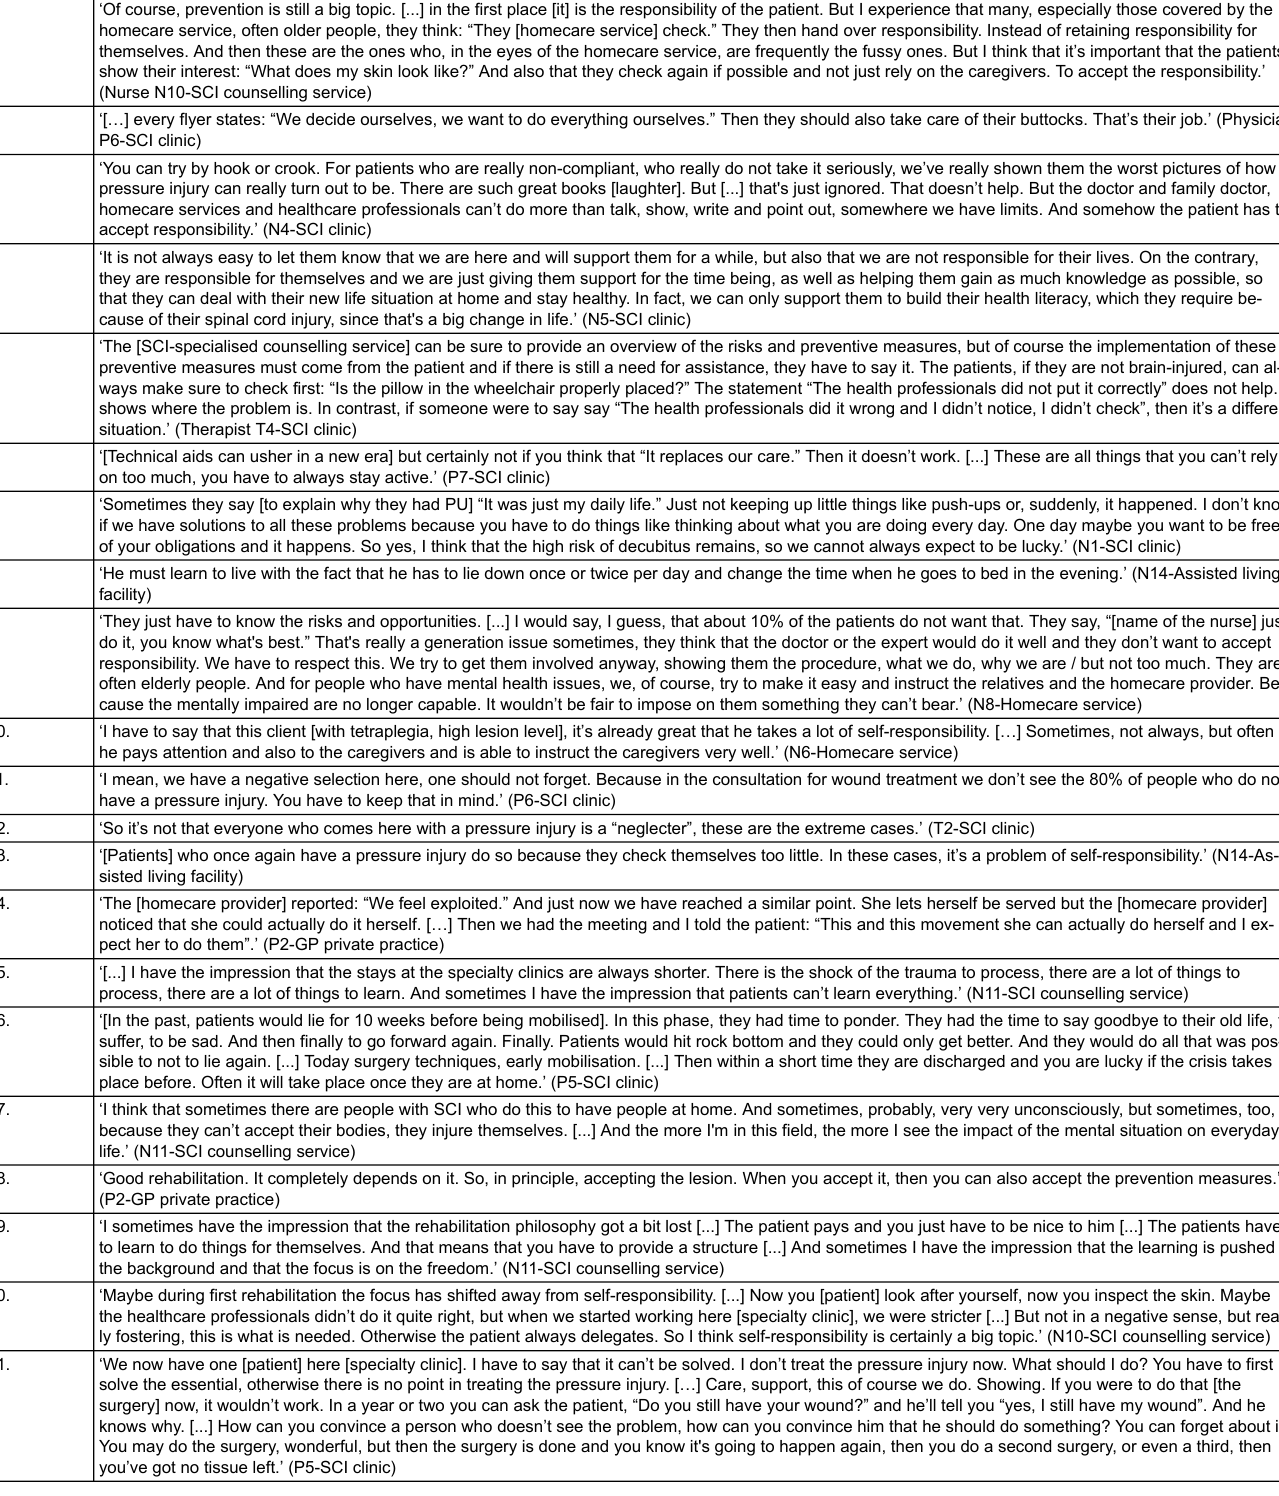
Table 3: Challenge 1 – defining responsibilities and